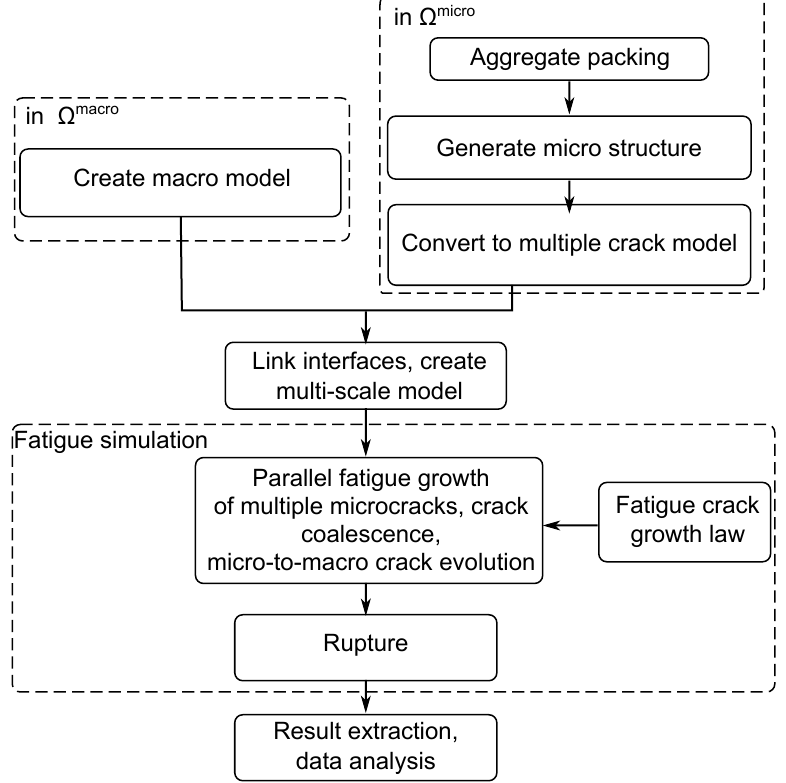
Figure 5. Algorithm for concrete fatigue